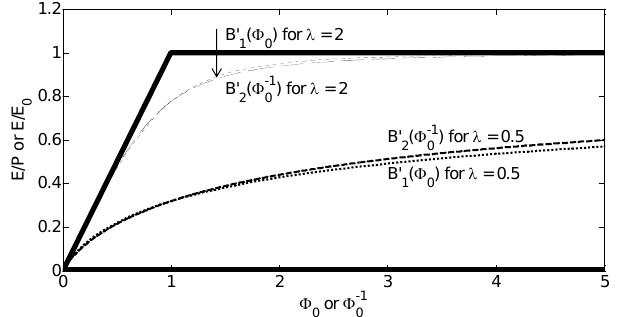
Figure 4. Comparison of functions E/P = B 1 (cid:48) ((cid:56) 0 ) (Eq. 20) and E/E 0 = B 2 (cid:48) ((cid:56) − 1 ) (Eq. 21) for two different values of the shape 0 parameter λ (0.5 and 2), b = 1 and α 0 = 1 . 26.